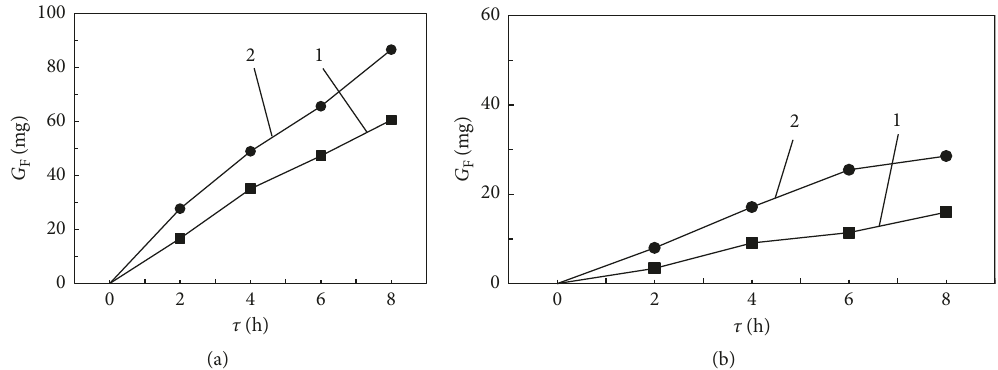
Figure 7: Wearing kinetics for friction pairs made of 40 Kh steel-40Kh steel after the VCH and hardening ((a) ring; (b) insert) under a load of 2MPa in an oil-abrasive environment: (1) VCH; (2) hardening with low tempering (200 ° C).